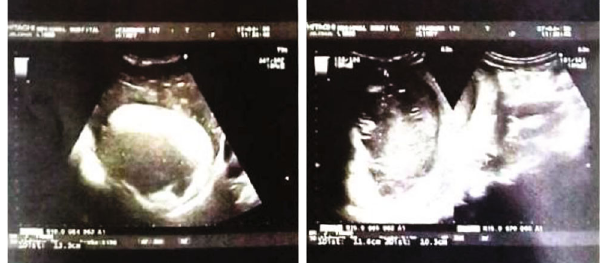
Figure 2: The ultrasound reveals a giant heterogenous mass with thick walls and air bubbles within the right lower lobe of the liver measuring 141mm suggestive of an amoebic liver